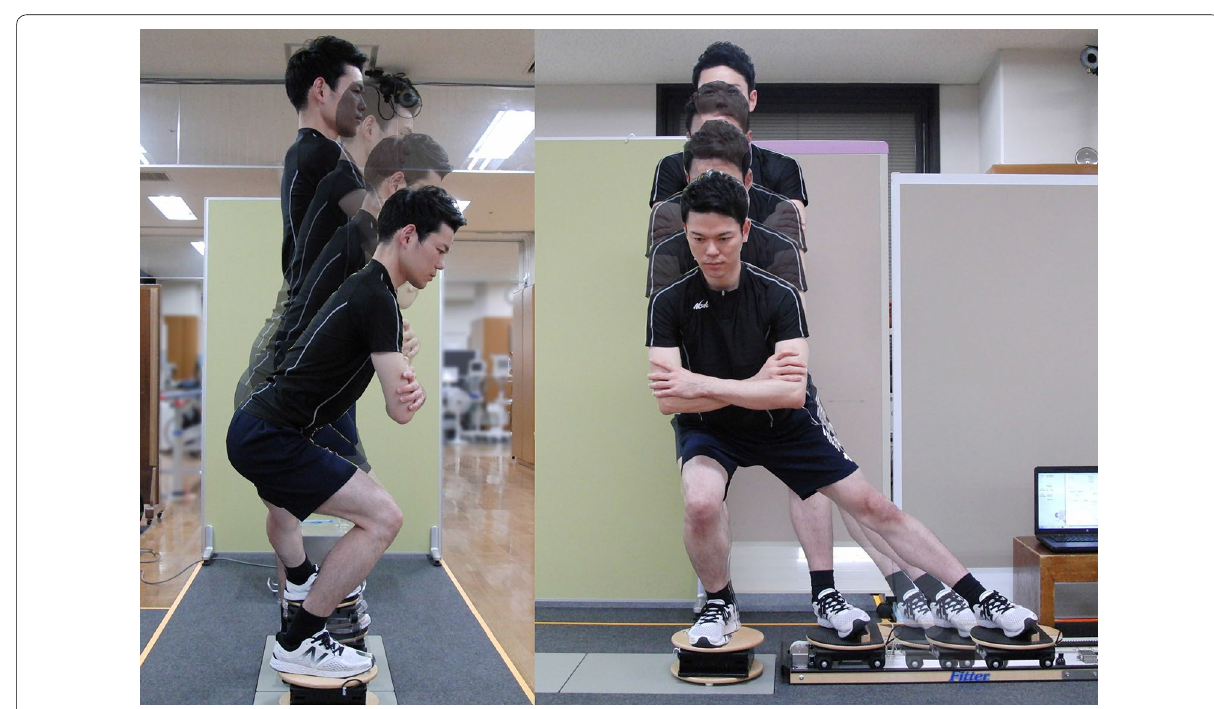
Fig. 2 Strobe of a single leg squat